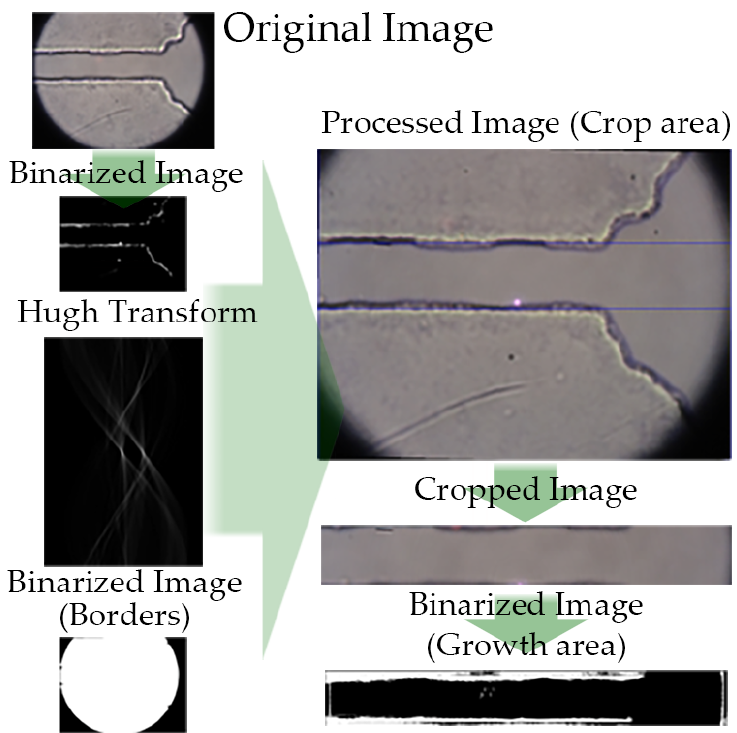
Figure A1. Schematic of the image analysis process. Briefly, the RAW image of the microchannel segment is binarized to detect borders. The image is then enhanced, cropped and a threshold algorithm is applied to differentiate bacterial growth from background.